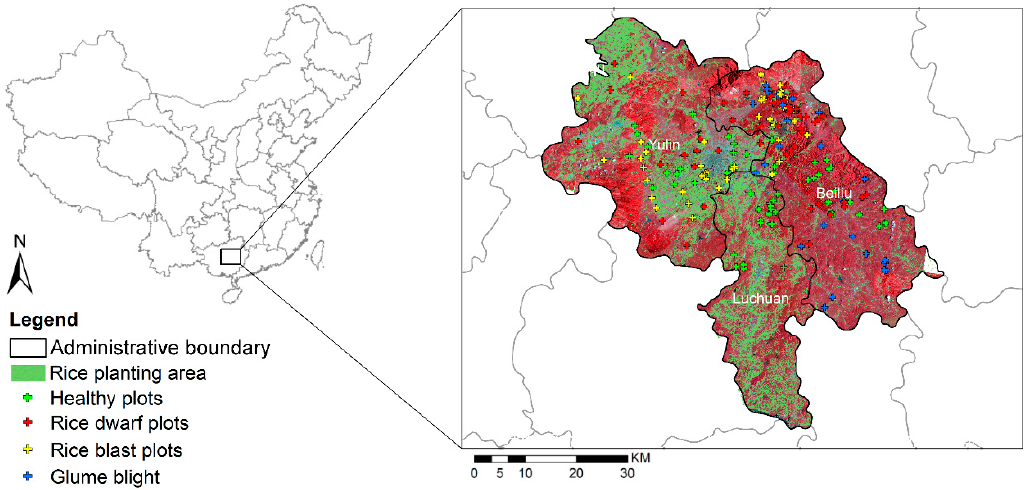
Table 1. The parameters and information for the selected PlanetScope imagery.